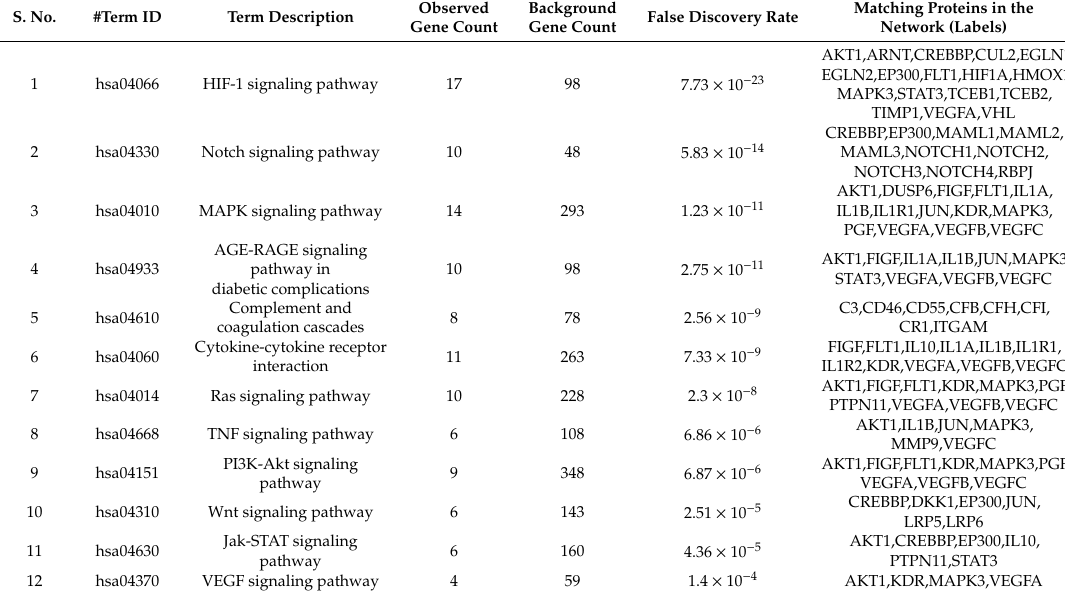
Figure 7. ( a ) Prediction of protein-protein interaction for the differentially expressed genes among PDR and RD in the present study. Protein 3D structure are enclosed in the circles. The colors of bond between the proteins indicate the evidences for their interaction (known interactions; skyblue-curated database, purple-experimently determined, other predicted interactions; lime-textmining, black-co-expression). Protein of interest studied are enclosed in dotted black circle ( b ) triangle-matrices, where the intensity of color indicates the level of confidence of two proteins which are functionally associated. Table 2. List of the important pathways involved in ERM pathogenesis. S.